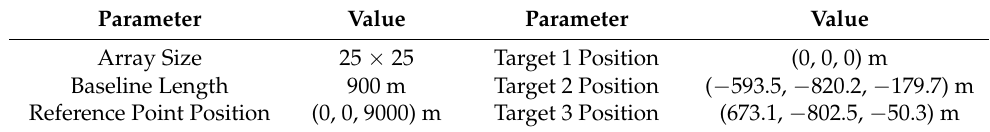
Table 2. Array and scene Table 3. Array and scene parameters.